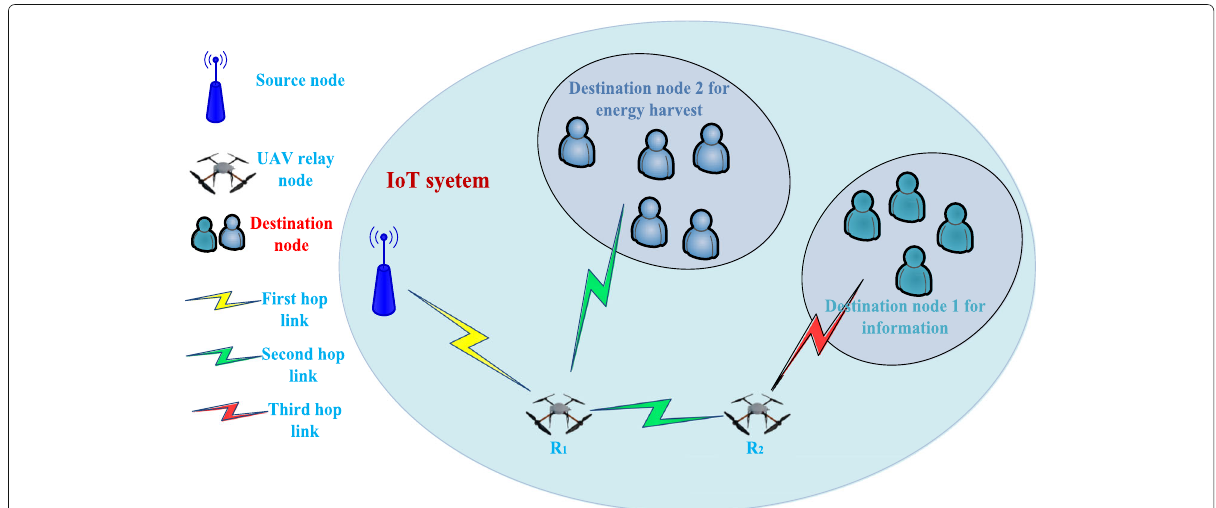
Fig. 1 The system model of energy and information wireless transmission with UAV relay